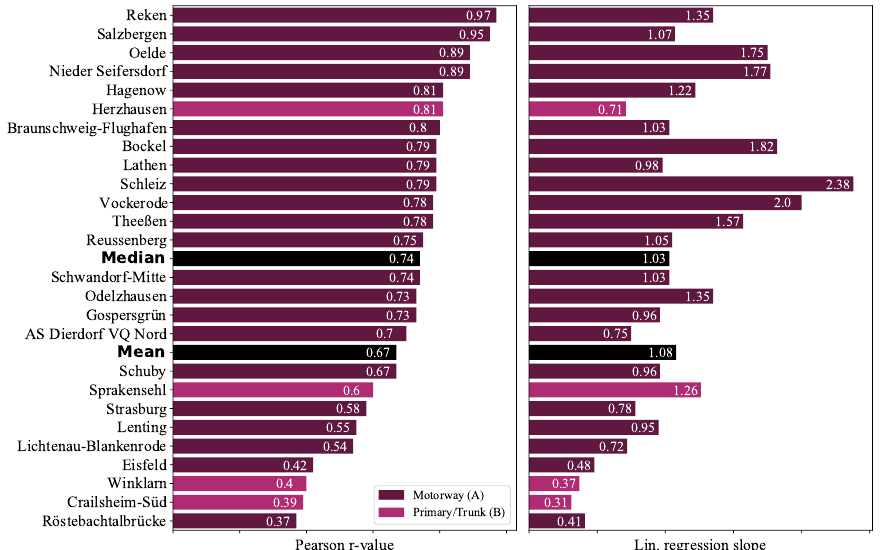
Figure 13. Comparison of Sentinel-2 truck counts with traffic count station figures: Station-wise r values and linear regression (x = Sentinel-2, y = station) slopes.